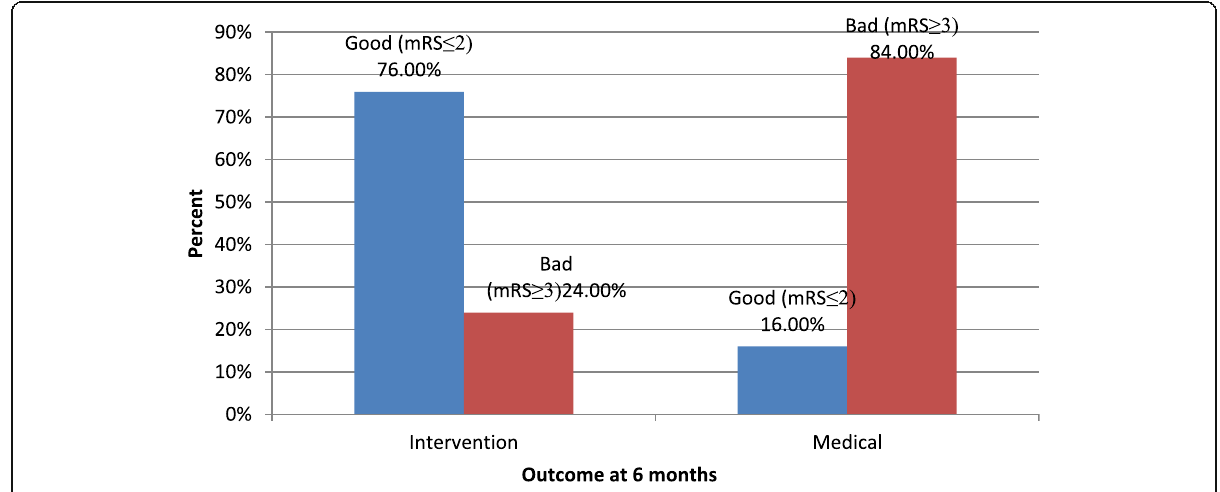
Fig. 5 Clinical outcome of both groups after 6